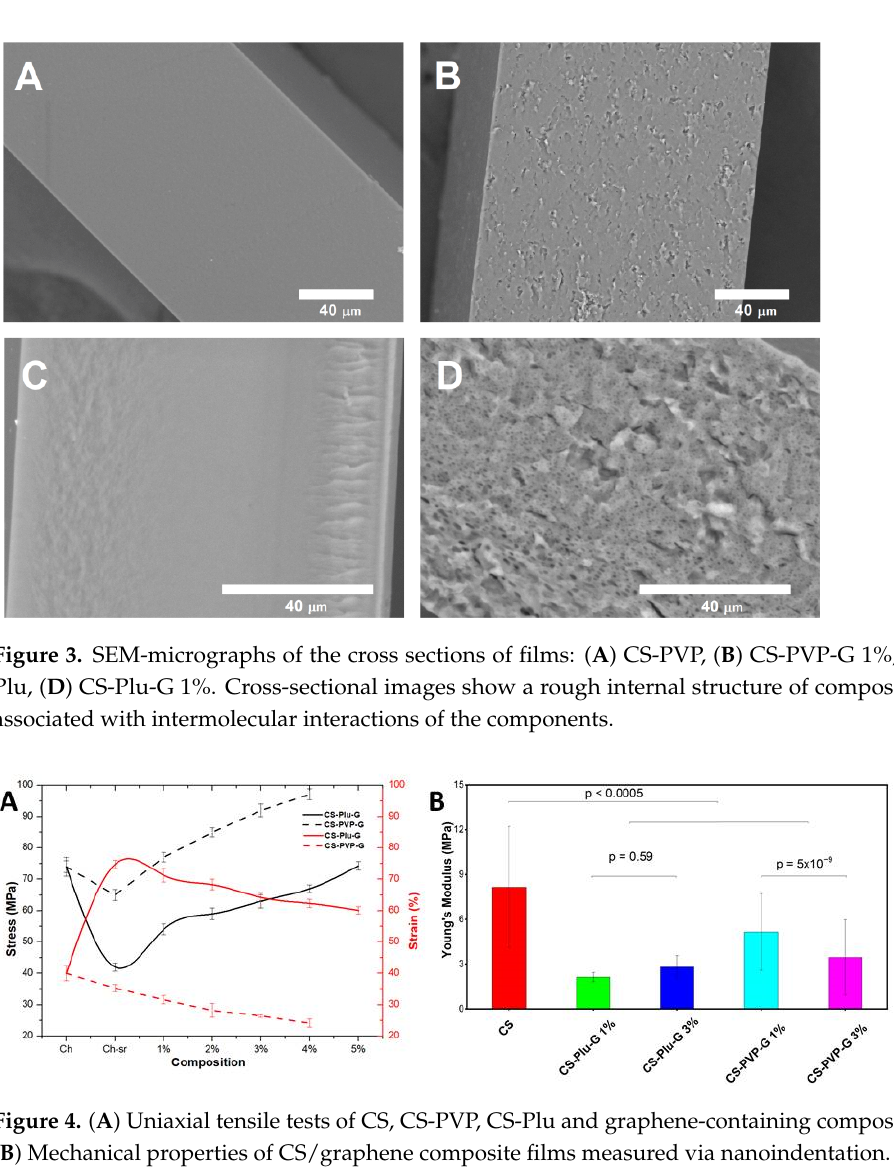
Figure 3. SEM-micrographs of the cross sections of films: ( A ) СS-PVP, ( B ) СS-PVP-G 1%, ( C ) CS- Plu, ( D ) CS-Plu-G 1%. Cross-sectional images show a rough internal structure of composite films associated with intermolecular interactions of the components.